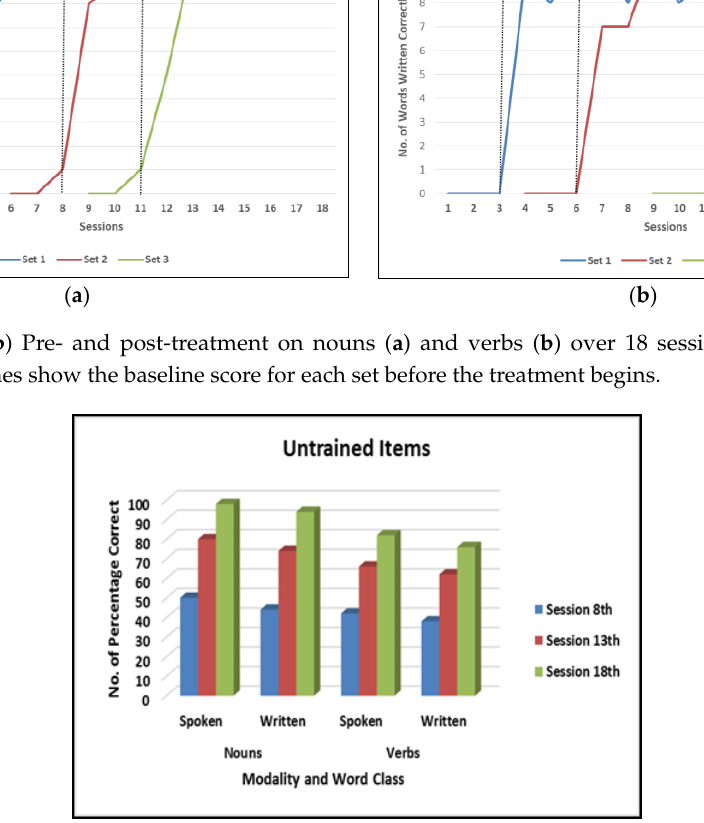
Table 1. Results of Western Aphasia Battery-Revised (WAB-R) and Pyramid Palm Tree Test (PPTT) pre-and post-treatment.